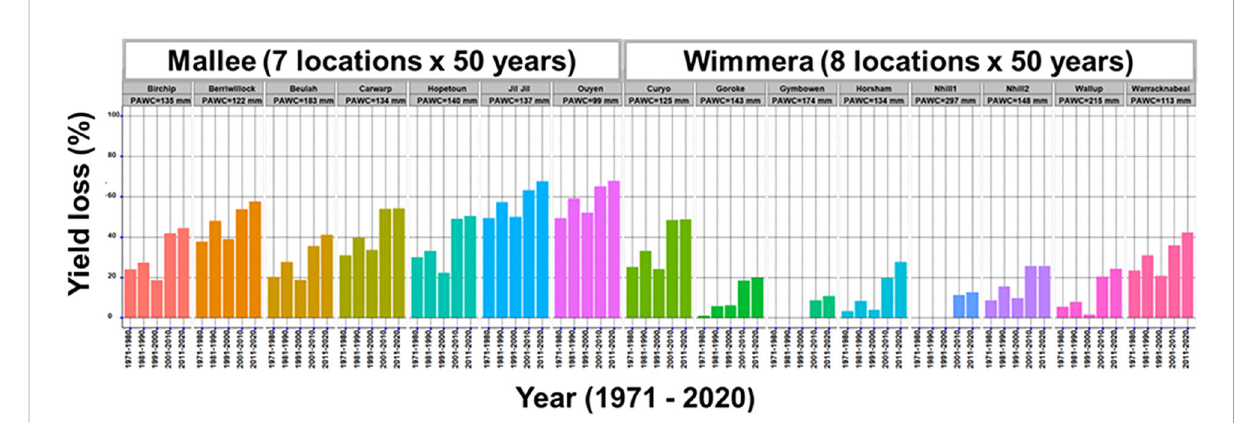
FIGURE 3 Predicted drought impact on lentils in Mallee and Wimmera environments of South-eastern